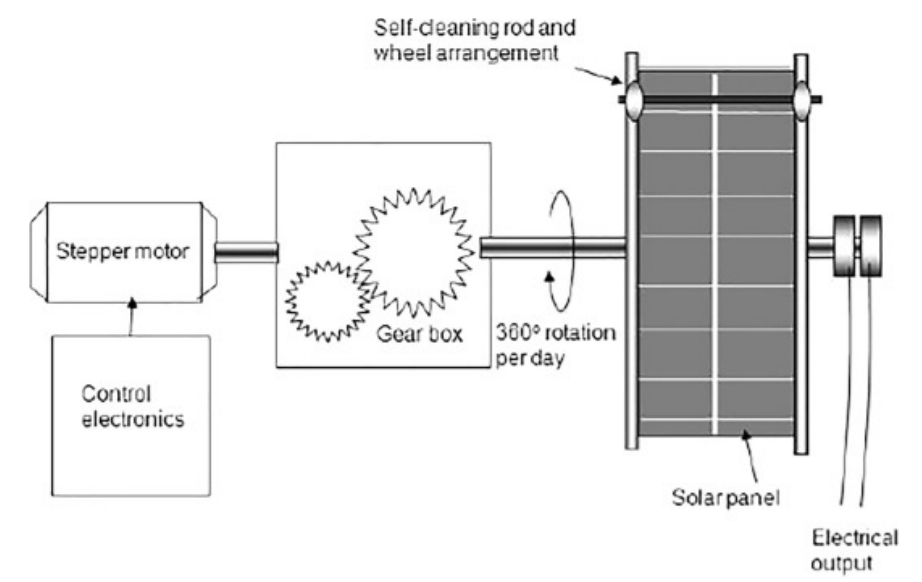
Figure 31. Mechanical cleaning with a solar tracking system [137].